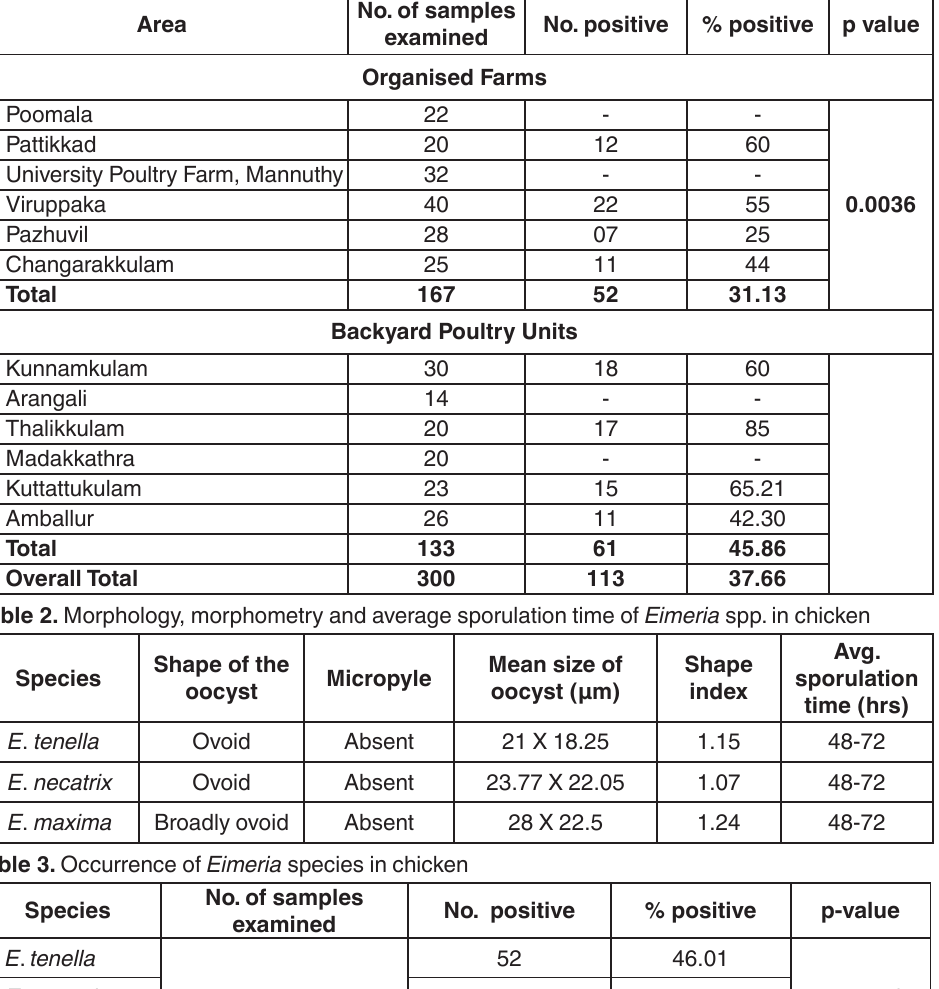
Table 1. Occurrence of Eimeria spp. in chicken in and around Thrissur Area